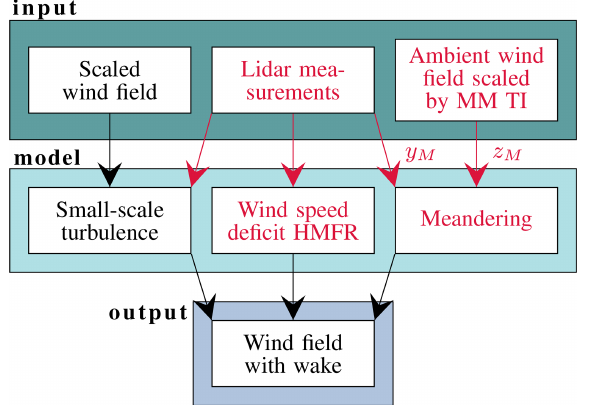
Figure 4. Incorporation of lidar measurements into the DWM model; y M is the horizontal and z M the vertical meandering com-